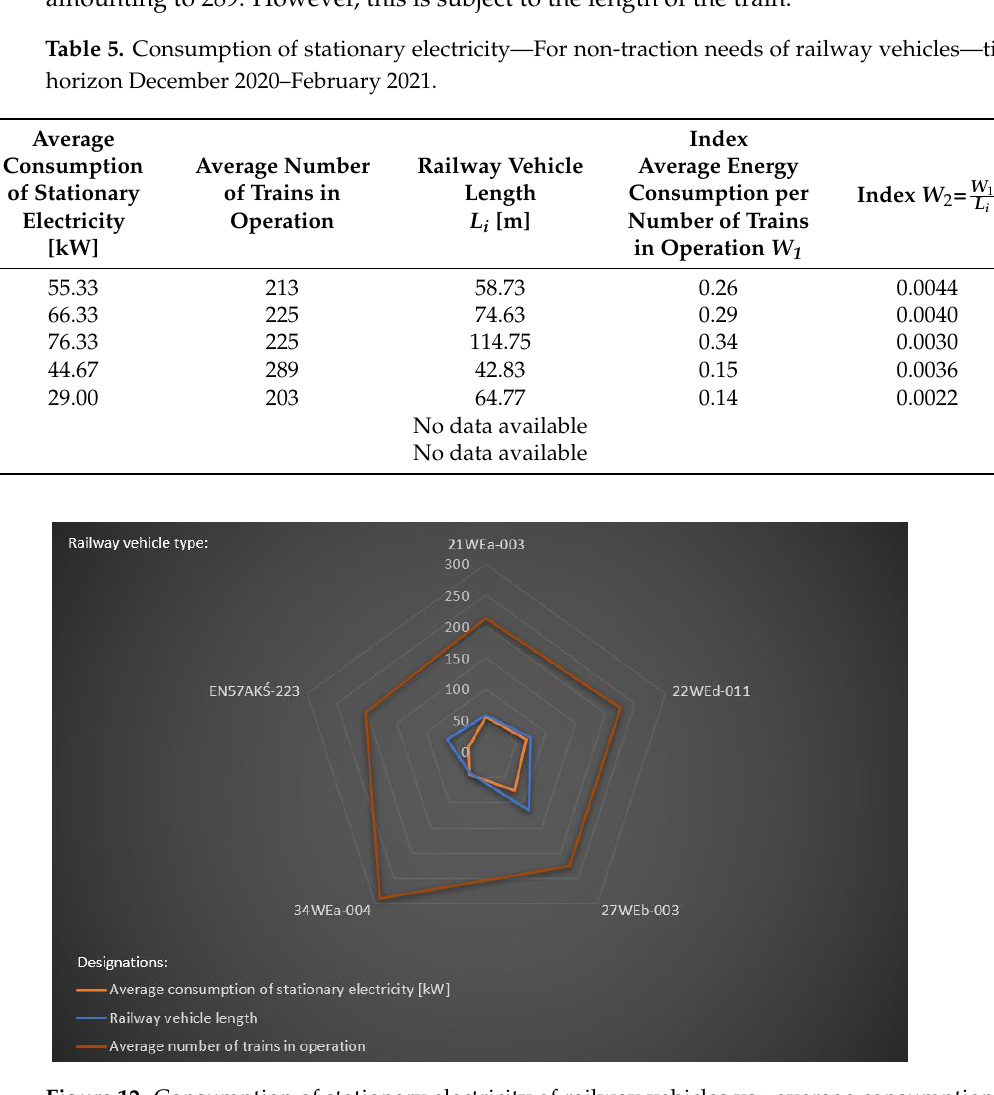
Figure 12. Consumption of stationary electricity of railway vehicles vs.: average consumption. of stationary electricity; railway vehicle length and average number of trains in operation